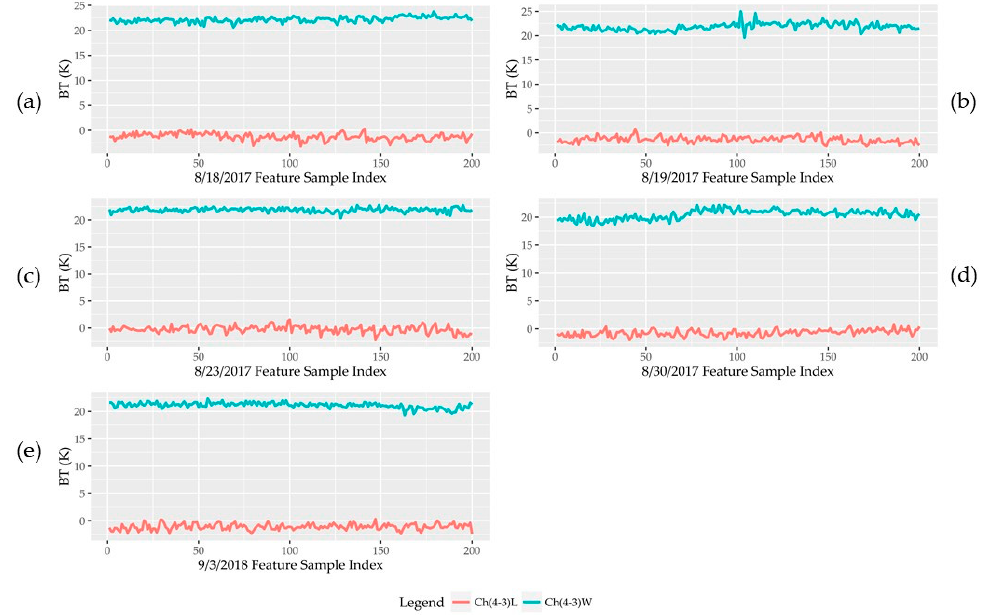
Figure 4. ( a – e ) show temperature (BT) di ff erences between channel 4 and 3 of land samples and water samples collected from 18–19, 23, & 30 August 2018 and 3 September 2018 ATMS data. Ch (4-3) W and Ch (4-3)L represent water and land samples’ brightness temperature di ff erences between channel 4 and 3 in ATMS data. It is obvious that the water samples have larger BT di ff erences compared with land